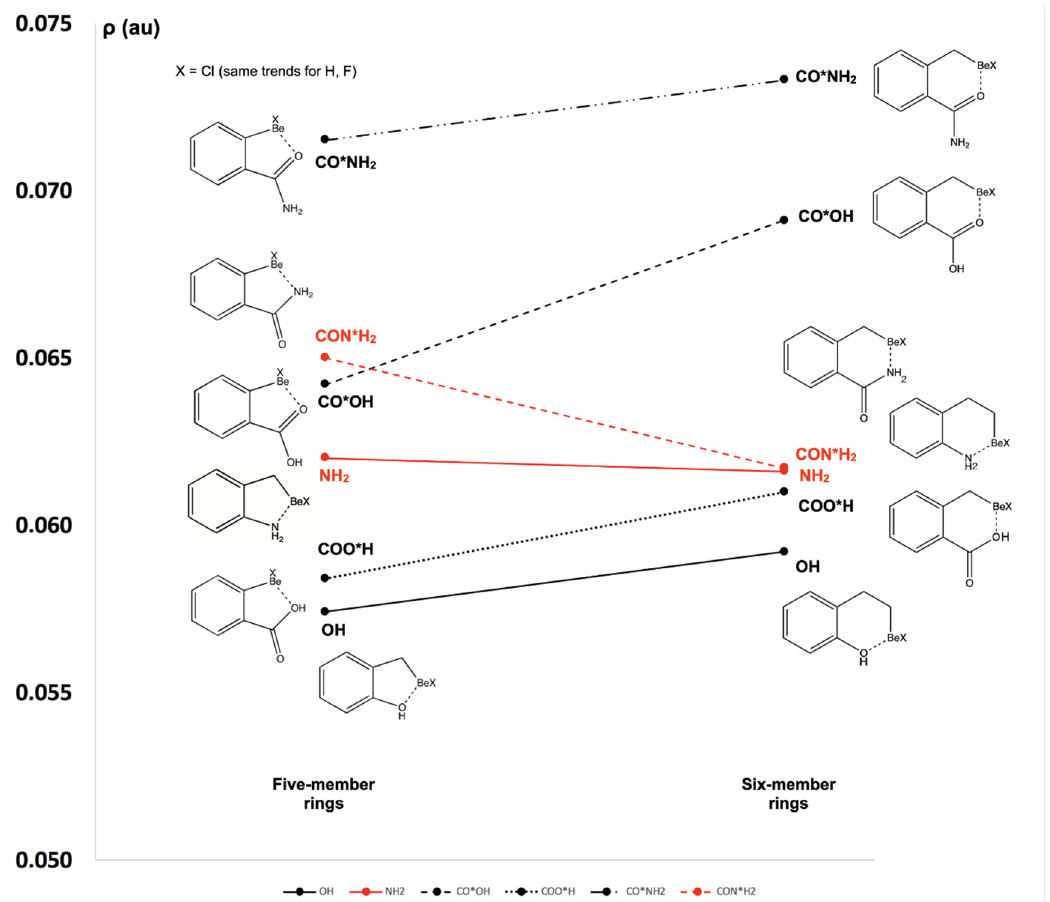
Figure 8. Comparison of density values for the pairs between (CH 2 ) n BeX, where X = Cl and O, N donors for the formation of five-member and six-member rings of different kinds (see Figure 2).